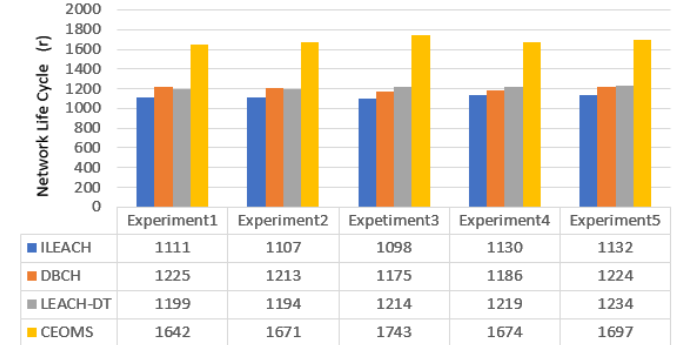
Figure 17. Network life cycle of the four